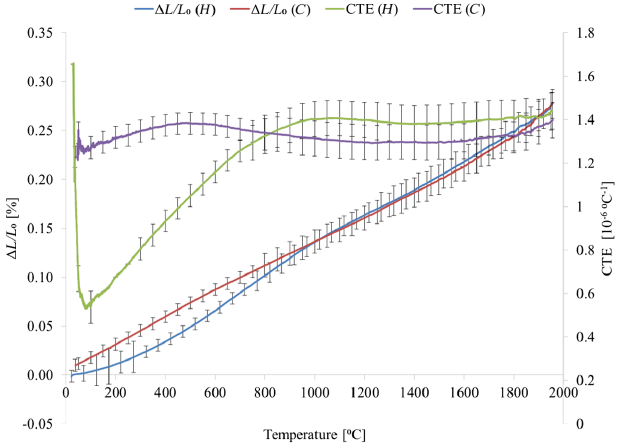
FIG. 11. Relative change in length and CTE against temper- ature with initial thermal reference of 100 °C ( H ) and 41 °C ( C ) for MoGr along ( L